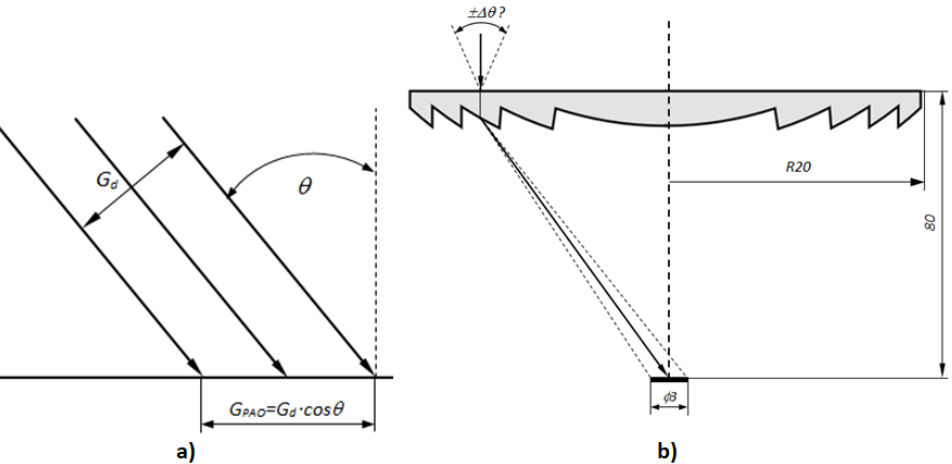
Figure 3. Models of directional deflection of incident radiation on the cell surface: ( a ) for a classical PV module (plane of array (PAO)), ( b ) for a CPV module with a point-focus Fresnel concentrator.